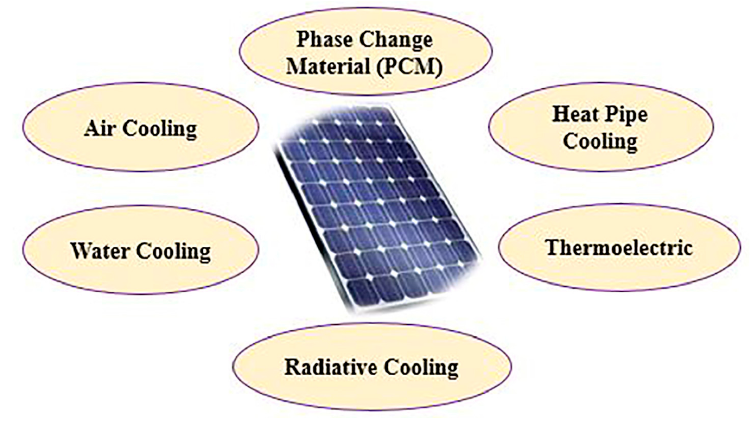
Figure 2. Six common cooling approaches for PV cells.